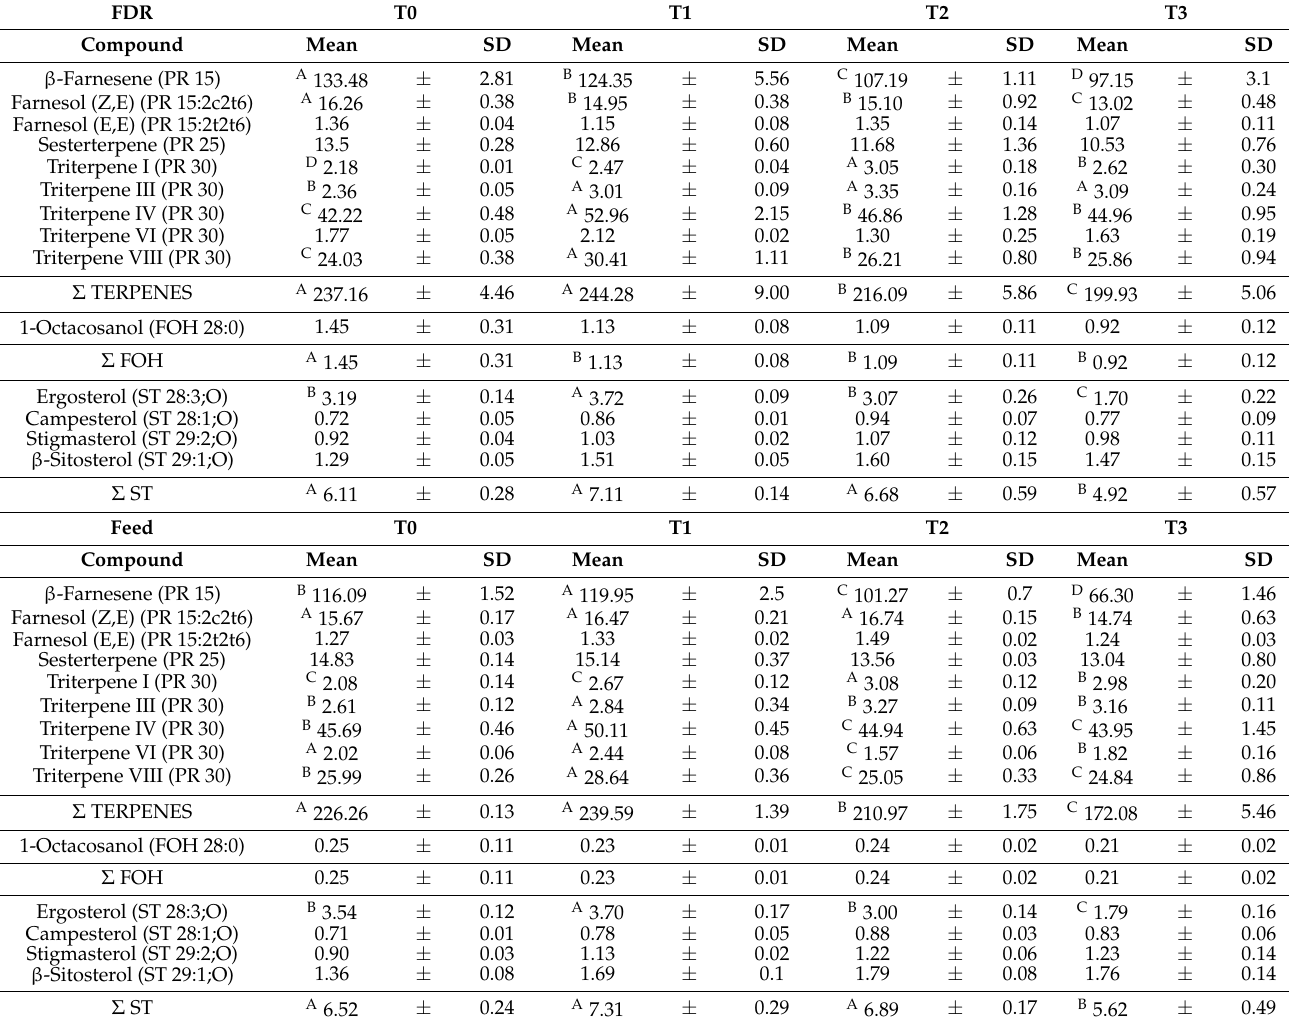
retention time) and labeled from I to VIII (Supplementary Materials Figure S1). Afterwards, the mass spectra of the matching peaks in each sample were compared. It was found that the fragmentation pattern of peaks with the same retention time was similar, therefore, suggesting that they were the same compound. In all cases, the base peak was 69 m/z, while the other secondary ions were 41, 55, 81, 95, 105, 120, 133, 145, and 160 m/z Figures S2–S5. The highest m/z detected was 408 m/z, which may point out to be the molecular ion. Thus, compounds I to VIII seem to belong to the same family but the differences in retention time highlight that they have some structural differences. Table 2. Profile (g/kg) in terpenes, fatty alcohols, and phytosterols in the FDR and Feed samples at the different assay